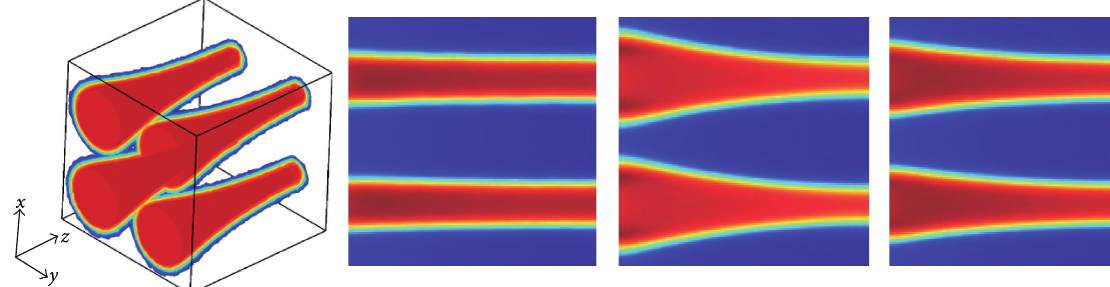
F 8: Blockage formation during SiC �ber deposited with